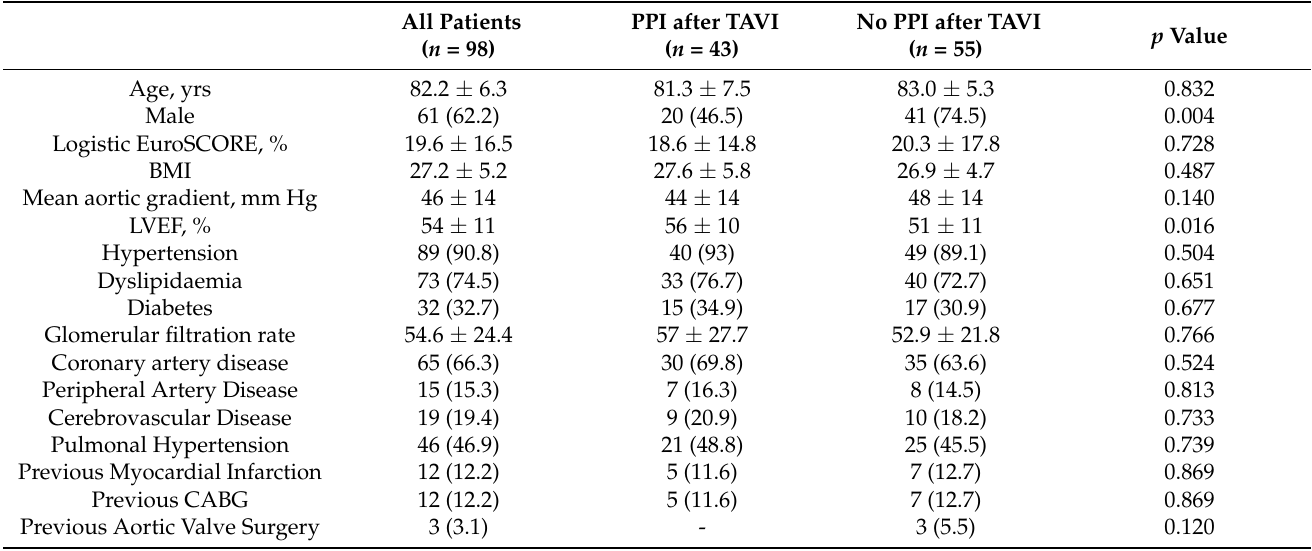
Table 1. Clinical characteristics of patients with pre-existing